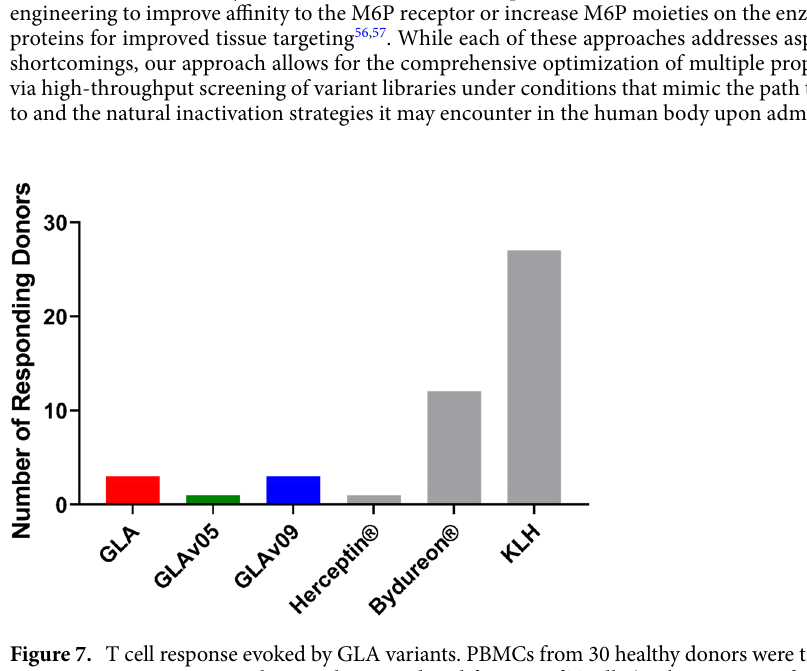
Figure 7. T cell response evoked by GLA variants. PBMCs from 30 healthy donors were treated with GLA, GLAv05, GLAv09, or controls in triplicate, and proliferation of T cells (in the presence of an inhibitor of CD8 + T cellswas measured by 3 H-thymidine incorporation on days 5, 6, 7, and 8. Donors showing a response on any day were considered